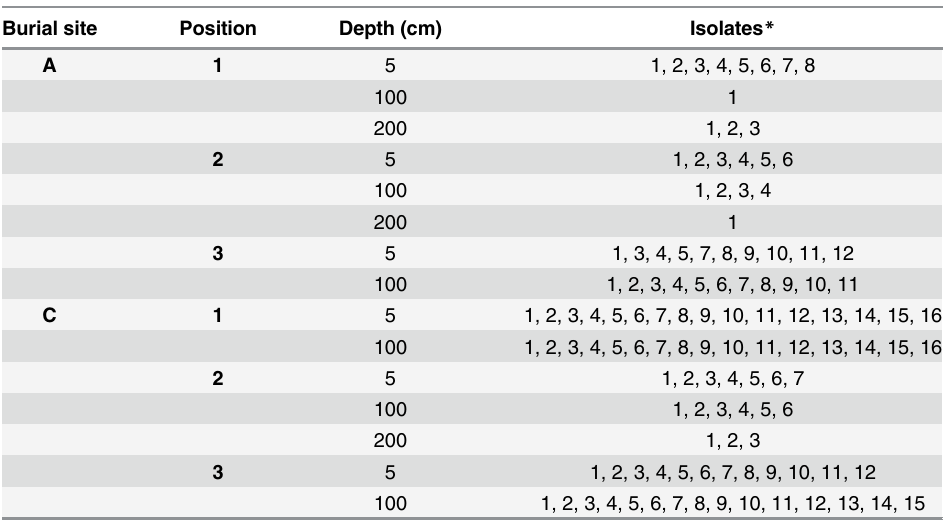
* no strains were recovered from site B and isolates from soil samples A3/200 cm, C1/200 cm and C3/200 cm were not characterized in this